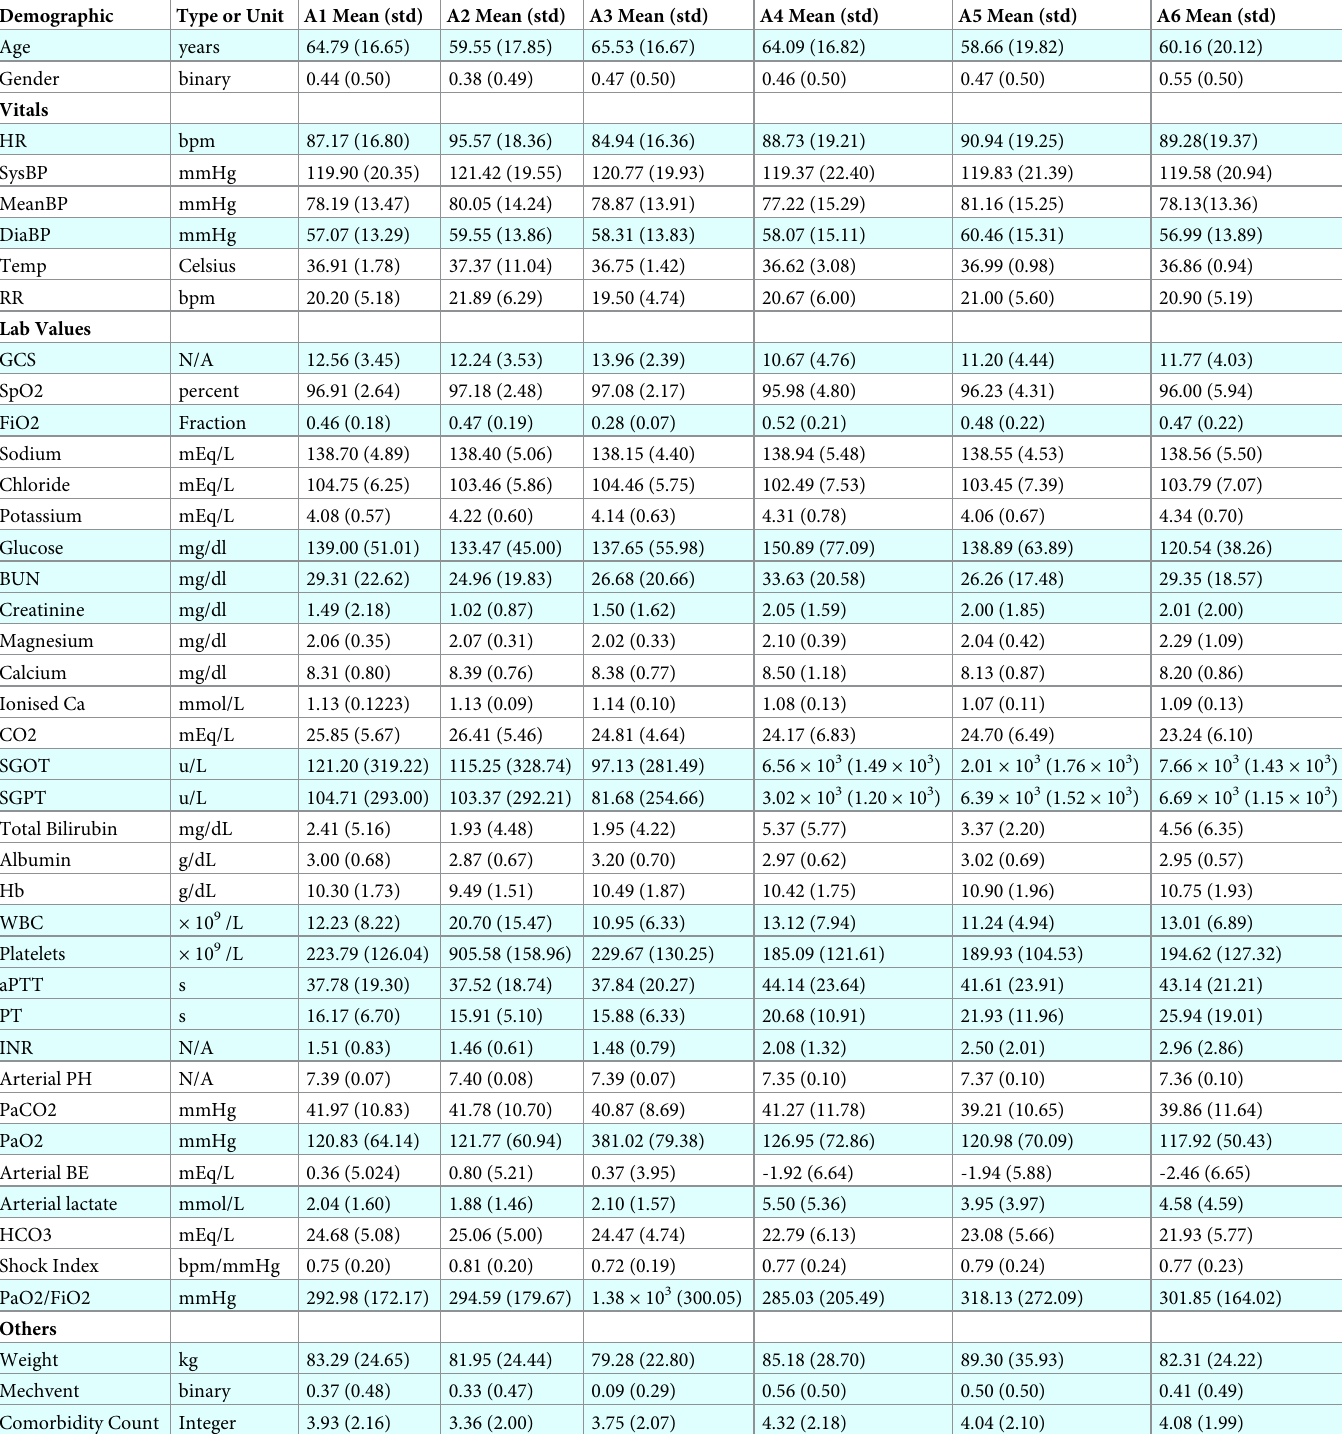
Table 2. Statistics of the clinical variables for each sepsis state. Clinical variables that are selected from our feature selections methods are highlighted with light cyan. Note that the average age, gender, and comorbidity count for each state are calculated as the average age, gender, and comorbidity count among the patients who have passed through the sepsis state of